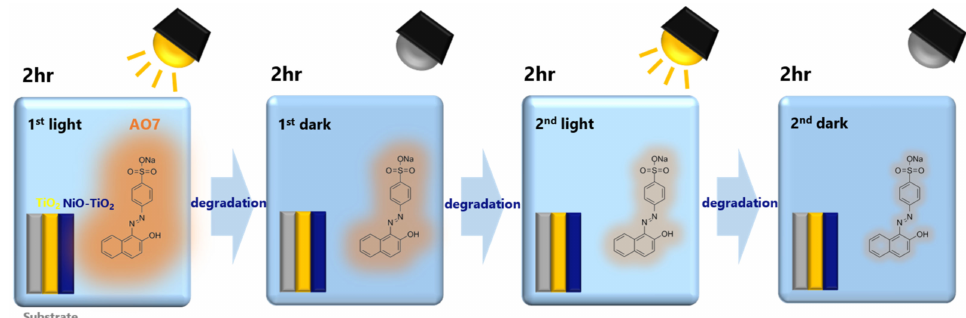
Figure 2. Schematic of the photocatalytic degradation measurement